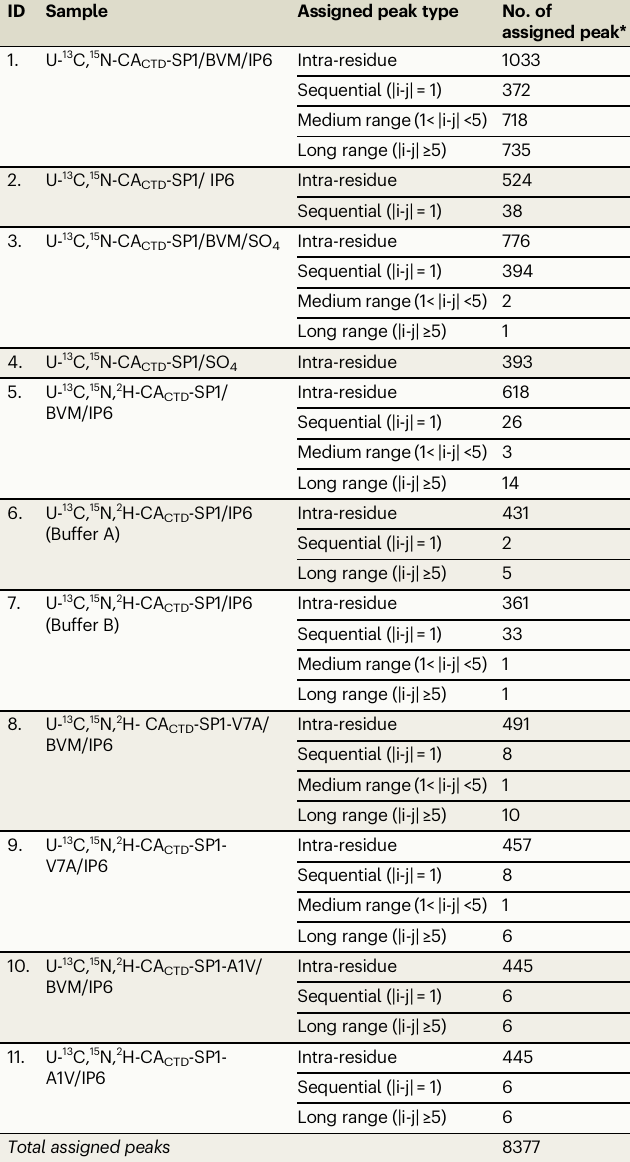
Table 2 | Summary of MAS NMR restraints and structure statistics